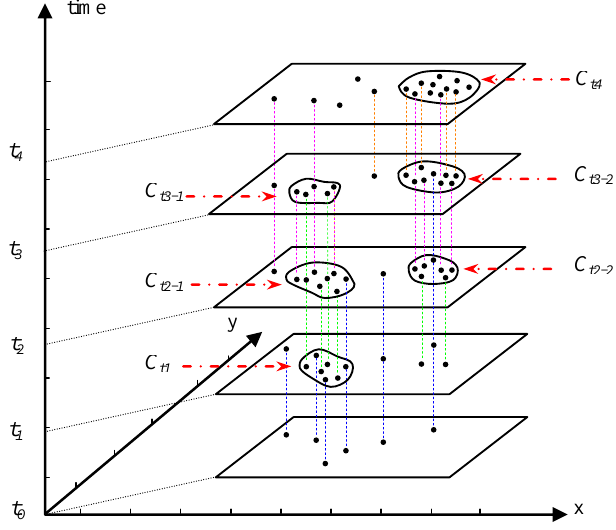
, t , t and t , 0 1 2 3